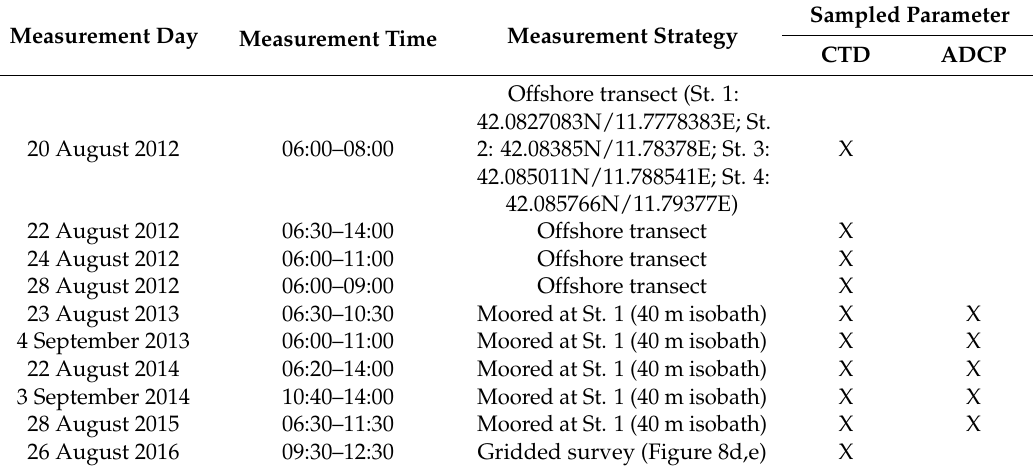
Table 1. Measurement strategies design using CTD (small instrument package contained an Idronaut 316 Plus multiparametric probe and a SeaPoint fluorometer) and ADCP (Acoustic Doppler Current Profiler) sampled